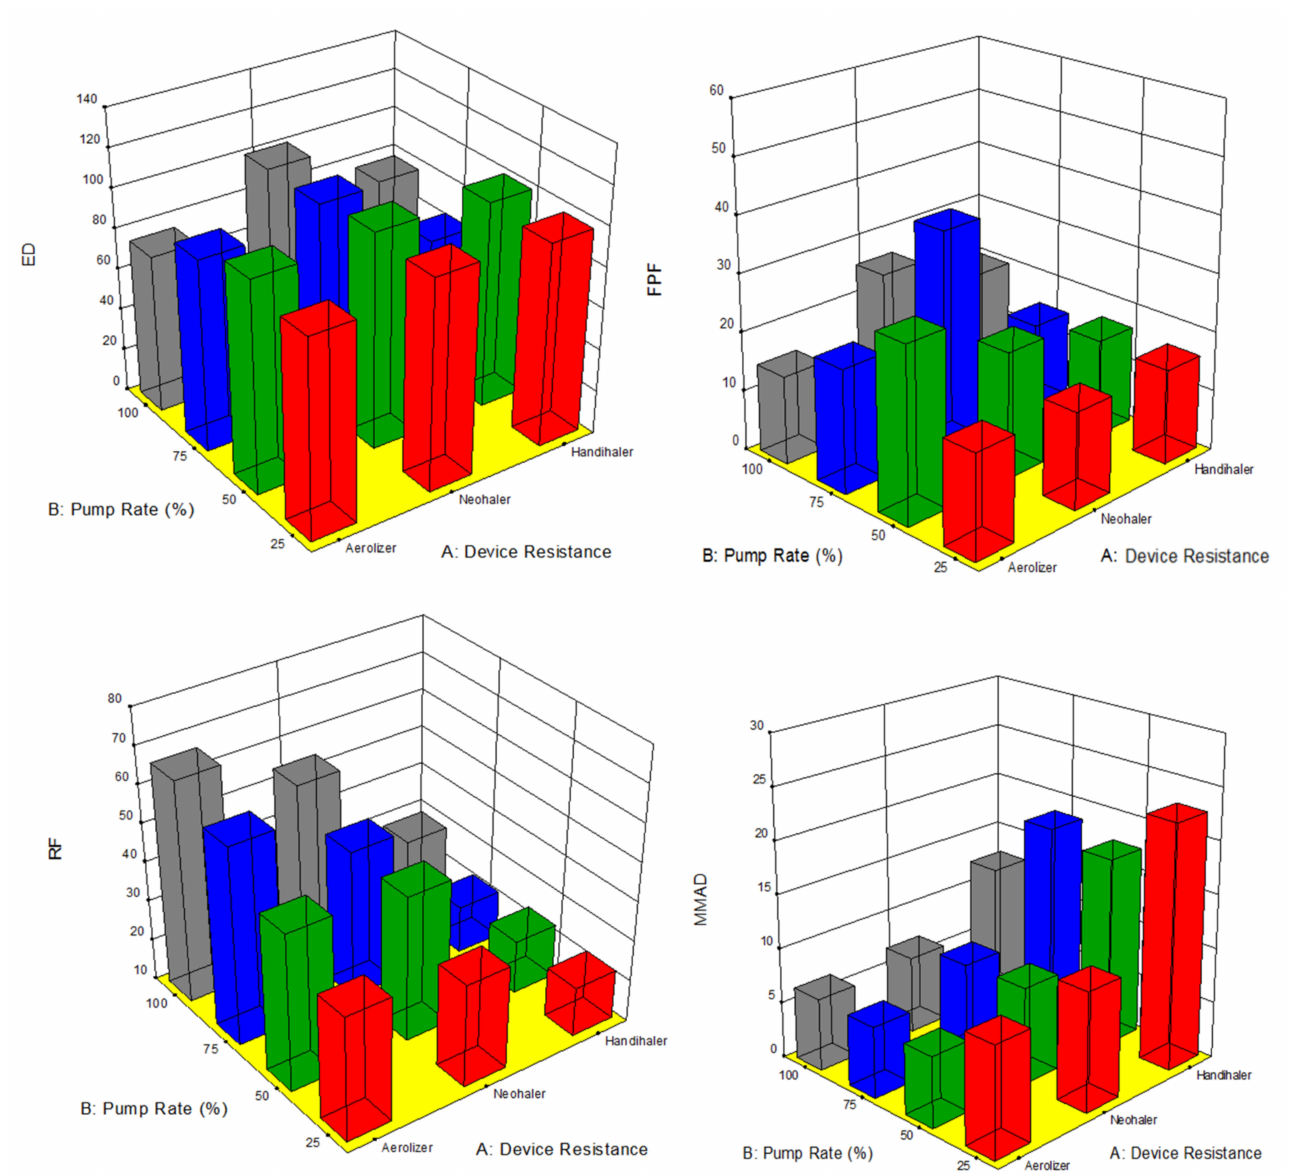
Figure 13. Design of experiments (DOEs) 3-D surface plots (Design Expert ® 8.0.7.1 software, Stat-Ease Corporation, Minneapolis, MN, USA) of spray drying pump rate and inhaler device resistance on in vitro aerosol performance parameters for all 4 SD FAS dry powders (25% PR, 50% PR, 75% PR, and 100%